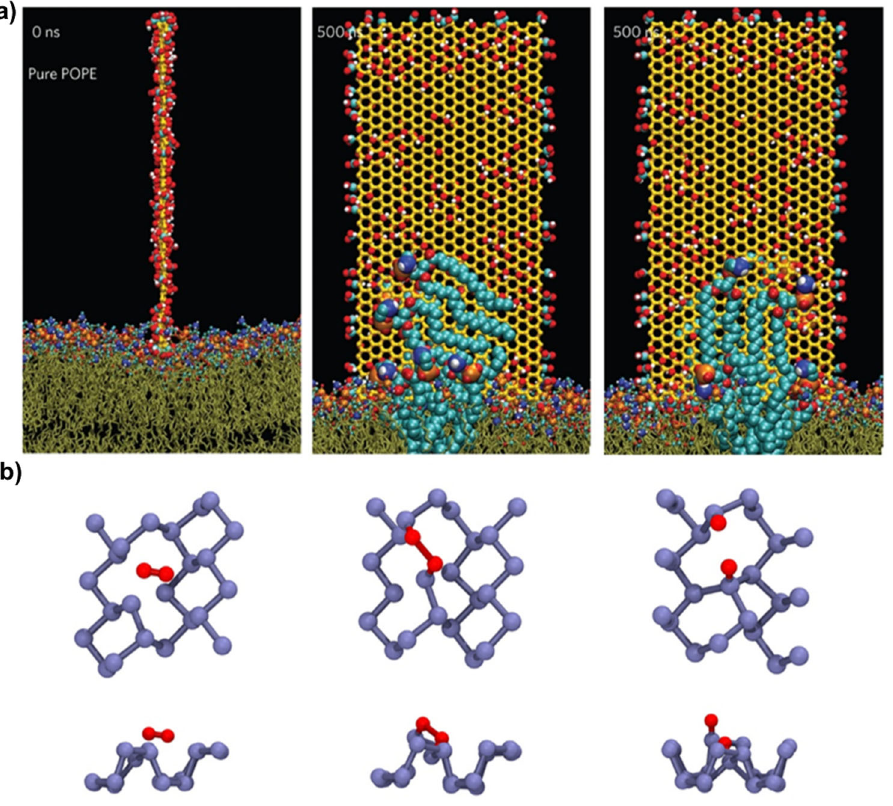
Fig. 6 Atomistic modelling of antimicrobial LDM behaviour. a Lipid extraction by graphene oxide nanosheets from the outer membrane surface 62 . b Top view and side view of the reaction of O 2 (red) with monovalent defect BP (purple) from QC